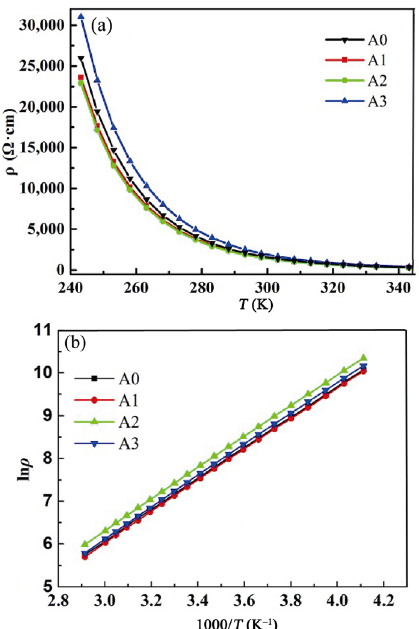
Fig. 8 Relationship between (a) resistivity ( ρ ) and absolute temperature ( T ), and (b) ln ρ and reciprocal of absolute temperature (1000/ T ) of A0, A1, A2, and A3 ceramics. Table 2 Room-temperature resistivity ( ρ 25 ), B